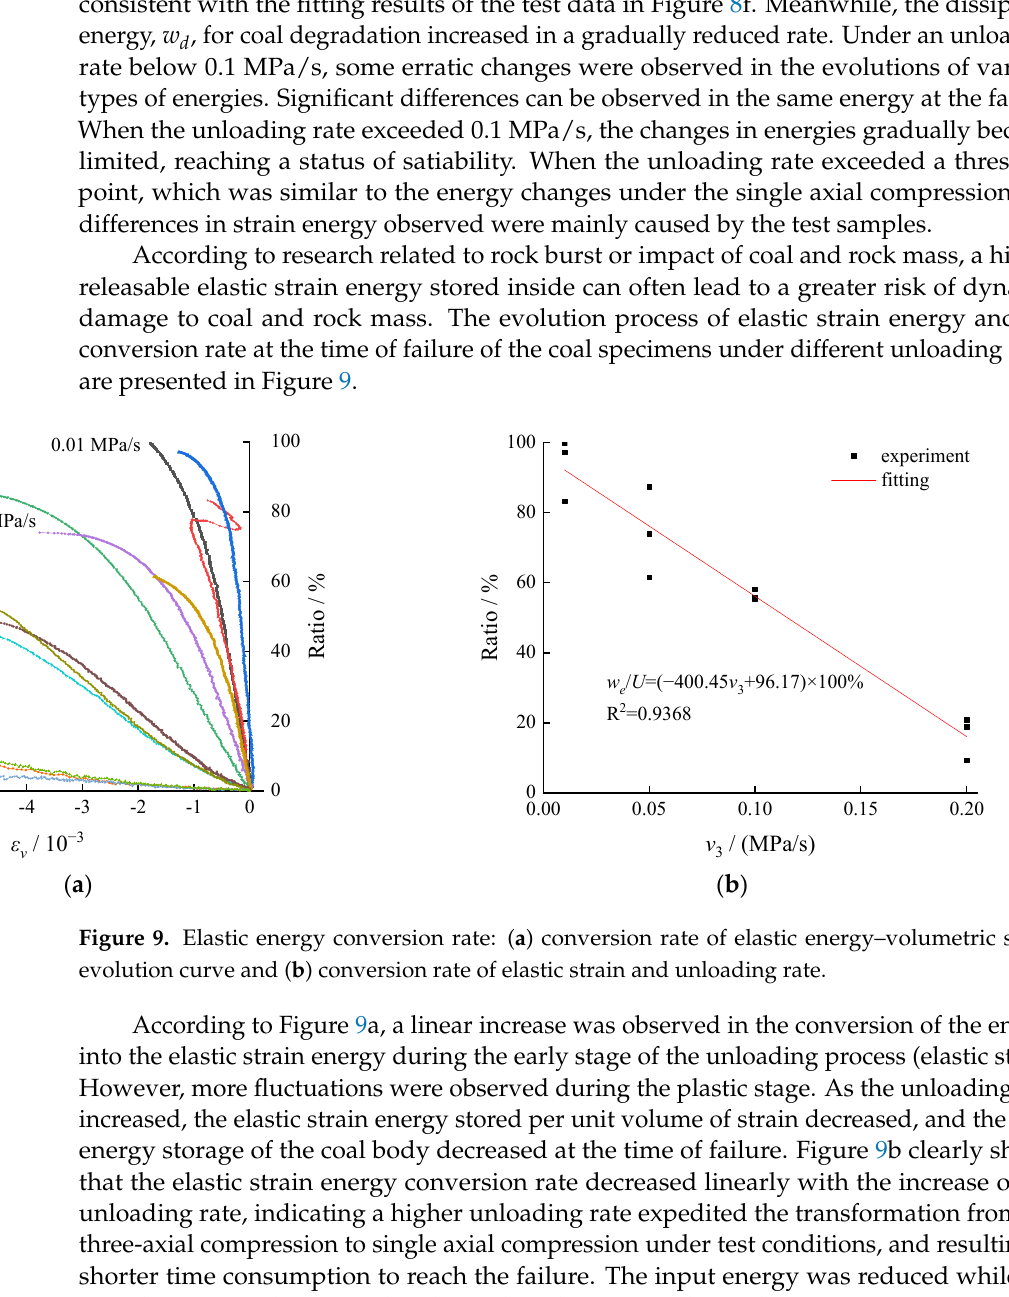
Figure 8. Energy evolution: ( a ) work of axial pressure, U 1 ; ( b ) work of confining pressure, U 3 ; ( c ) total work, U ; ( d ) elastic strain energy, w e ; ( e ) plastic strain energy, w d ; and ( f ) energy and unload- ing rate.